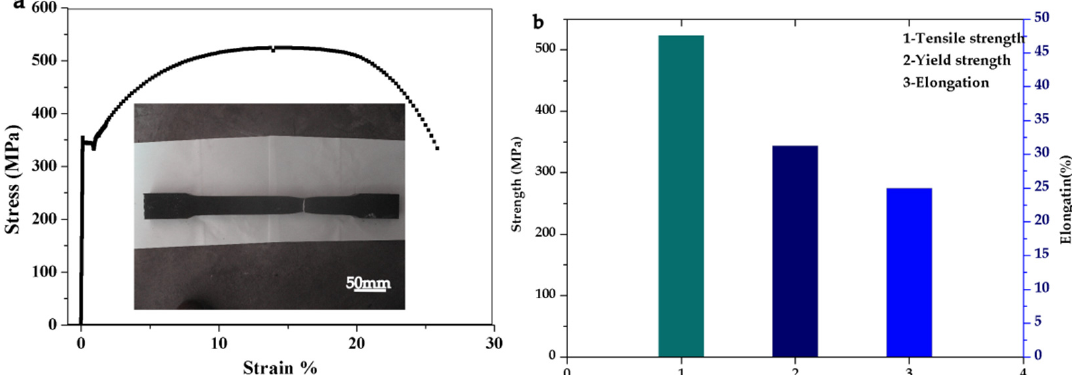
Figure 8. Tensile test: ( a ) fractured tensile specimen and tensile curve of the clad plate; ( b ) tensile strength, yield strength and elongation values.